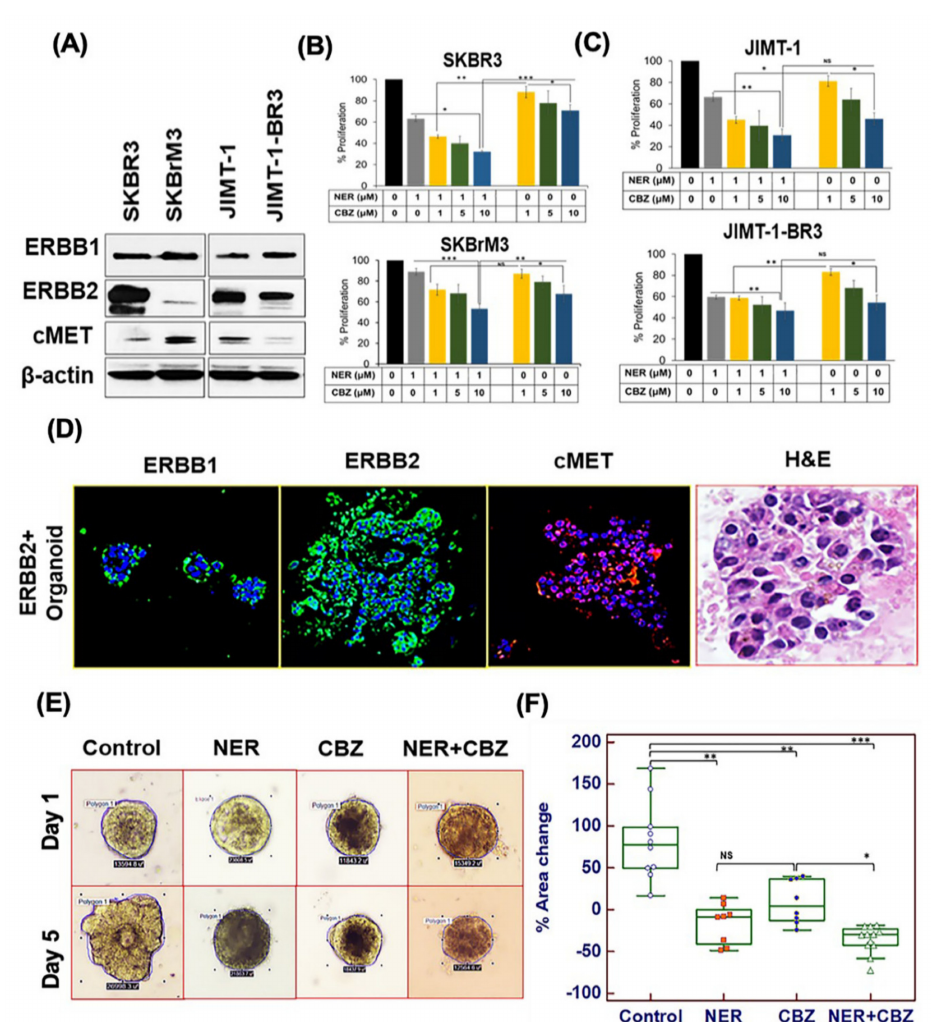
Figure 1. E ff ect of targeting ERBB1 and c-MET on cell proliferation in brain-seeking breast cancer (BC) cell lines and huHER2 tumor-derived organoids. ( A ) Expression of ERBB1, c-MET receptor, and ERBB2 in brain-seeking cell lines SKBrM3 and JIMT-1-BR3 and their respective parental cell lines SKBR3 and JIMT-1 by Western blotting. ( B , C ) E ff ect of treatment with NER, cabozantinib (CBZ), or their combination on proliferation of SKBrM3 and JIMT-1-BR3 cells as compared to their parental cell lines. The x-axis shows the treatment group for each cell line, whereas the y-axis shows percent cytotoxicity in di ff erent combination treatments in the MTT assay. Concentrations of each treatment are mentioned on X-axis. ( D ) Expression of ERBB1 (Alexa488), ERBB2 (Alexa488), and c-MET (Alexa568) receptors analyzed by immunofluorescence assay. H&E staining in the right panel shows the morphology of the organoids. The scale bar for IF images was 20 µ m, whereas the scale bar for H&E of organoids in right panel was 100 µ m. ( E , F ) E ff ect of treatments on organoids. Panel E shows a representative image of each group including control, NER, CBZ, and their combination (scale bar = 200 µ m), whereas panel F shows quantitative data for the e ff ect of drugs on the growth of huERBB2 + organoids. The area for each organoid was calculated in µ m 2 , and the percent change in area of organoids (y-axis) was plotted for each treatment group (x-axis). Growth was measured in n = 8 organoids for NER and CBZ treatment groups and n = 10 and n = 11 organoids for control and combination groups, respectively. The statistical significance among di ff erent groups was calculated by one-way ANOVA with * p < 0.01; ** p < 0.001; and *** p < 0.0001; NS = No